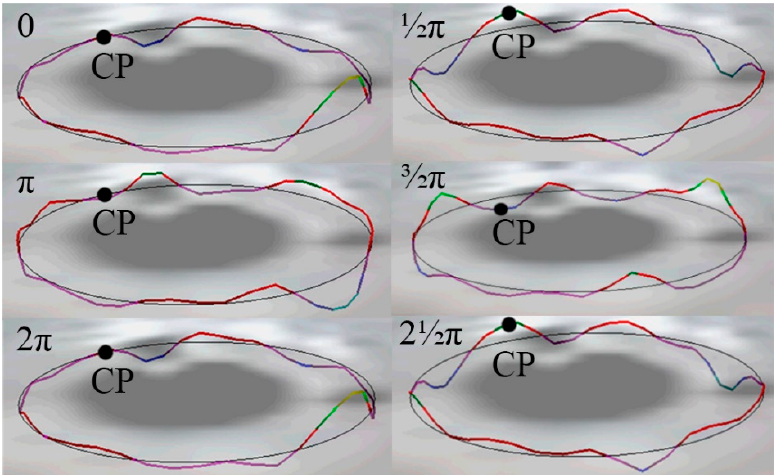
Figure 9. Displacement trajectory of the contact point over time; CP is a contact point.